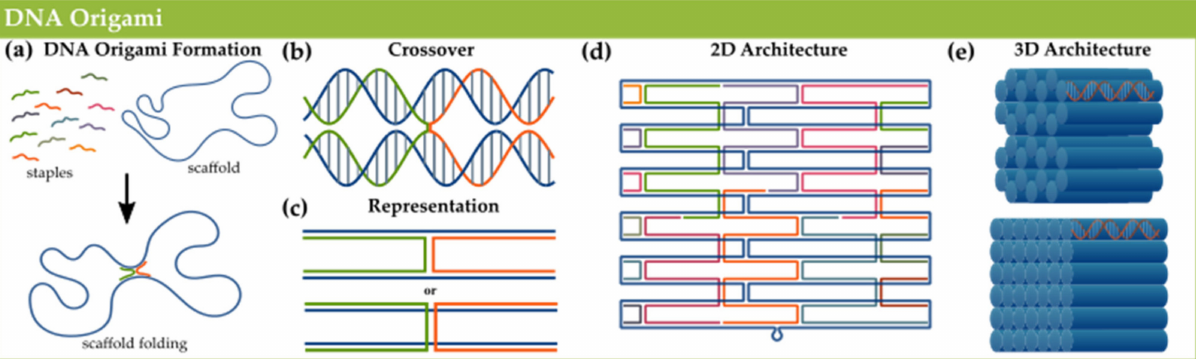
Figure 1. DNA origami folding method: ( a ) DNA origami nanostructures are assembled from the directed folding of the scaffold strand (blue) by staple strands (multicolored); ( b ) Individual helical domains are connected by interhelix crossovers; ( c ) These interhelix crossovers are represented as straight vertical segments; ( d ) CaDNAno editing is done using a simple 2D visualization of a DNA origami nanostructure that folds into a 3D model; ( e ) These 3D DNA origami models represent the DNA double helix as a solid cylinder and generally follow a honeycomb (top) or square (bottom) lattice architecture (adapted from Wang et al.